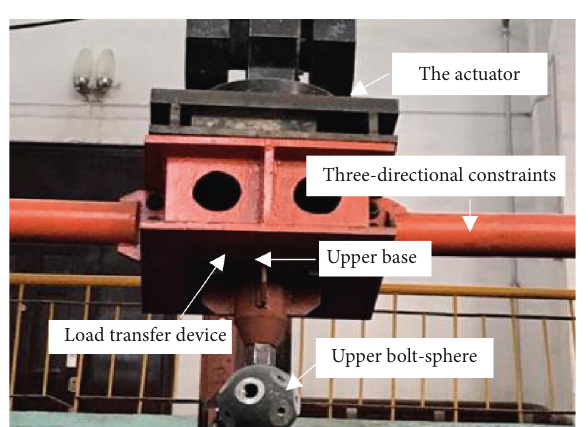
Figure 5: Load transfer device details.